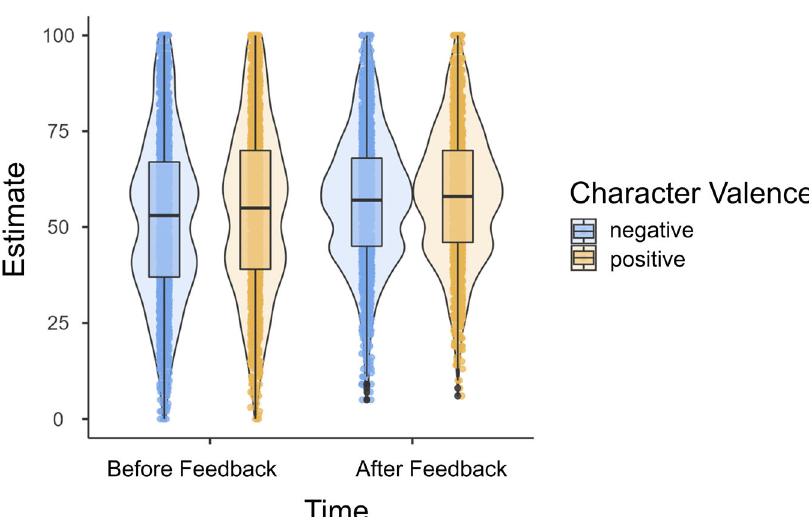
Fig. 4 Estimated probability of successful passes as a function of Character Valence and Time. Violin and box plots depicting the main effects of Character Valence and Time. Positive valence refers to self and indirect in-group, negative valence to rival and indirect out-group. The average feedback score given to the participants was M = 75.1% (SD =